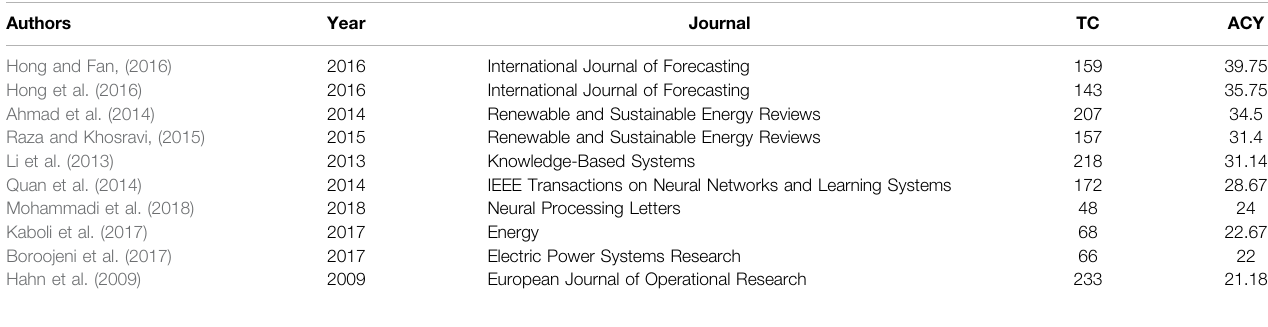
TABLE 5 | Highly average annual cited publications in electricity demand